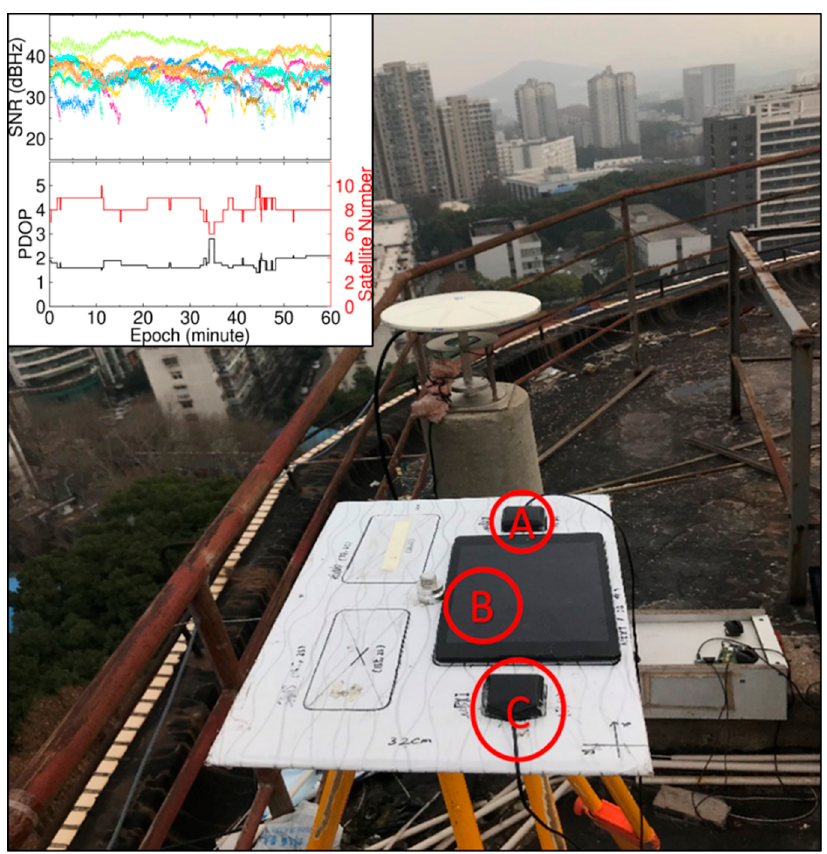
Figure 6 . Illustration of the static experiment configuration of GNSS receivers and antenna. Two patch antennas, i.e., A and C, and Nexus 9 tablet, i.e., B, were placed on the experiment board, beside which there was a high-quality Trimble antenna. The analyses including SNR (Signal-to-Noise Ratio), PDOP (Position Dilution of Precision) and observed satellite number for the static experiment are plotted in the left top panel. The dots with different colors in the SNR subfigure denote different satellites.